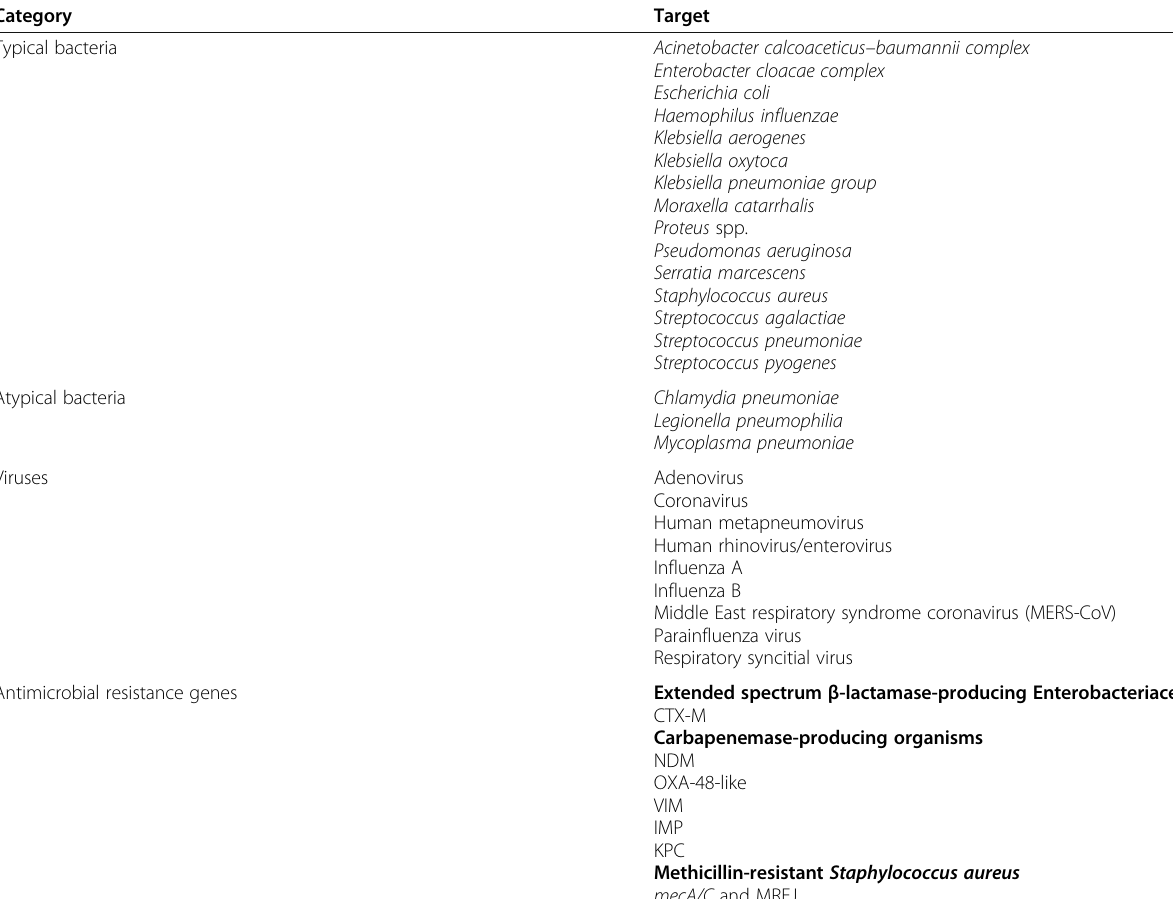
Table 1 FilmArray Pneumonia Panel plus